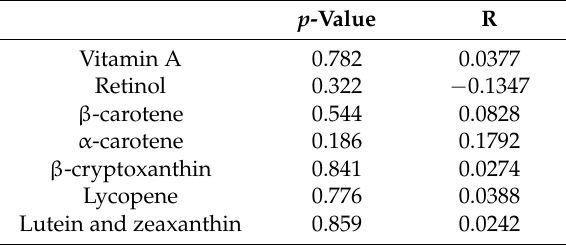
Table 3. Analysis of correlation (Spearman’s rank correlation) between fiber intake and retinoid intakes. p